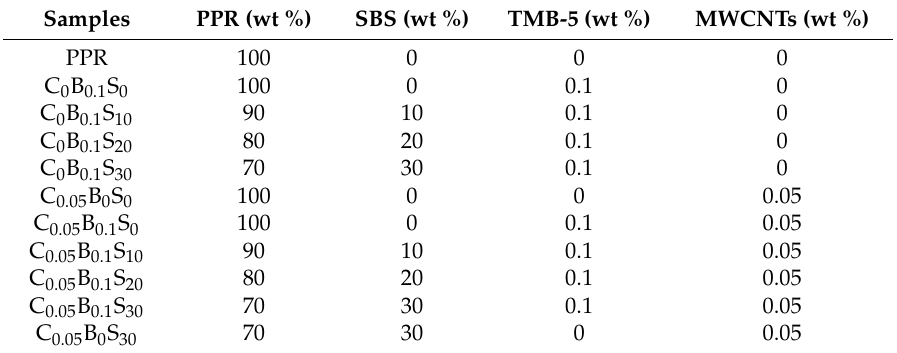
Table 1. Sample codes and ingredients of all the Polypropylene random co-polymer (PPR) blends.